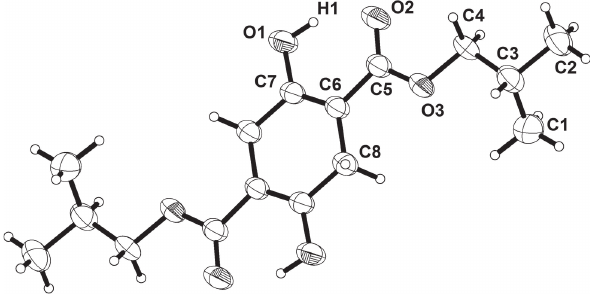
Table 1: Data collection and handling.